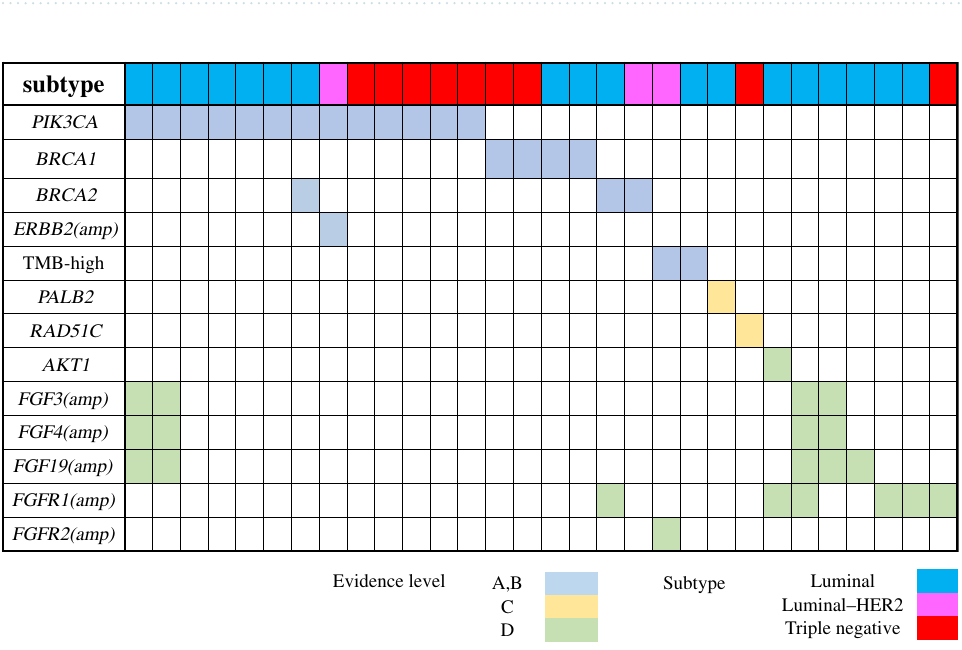
Figure 2. Type and frequency of identified genetic variants. The gene mutations and amplifications detected in this study are shown.